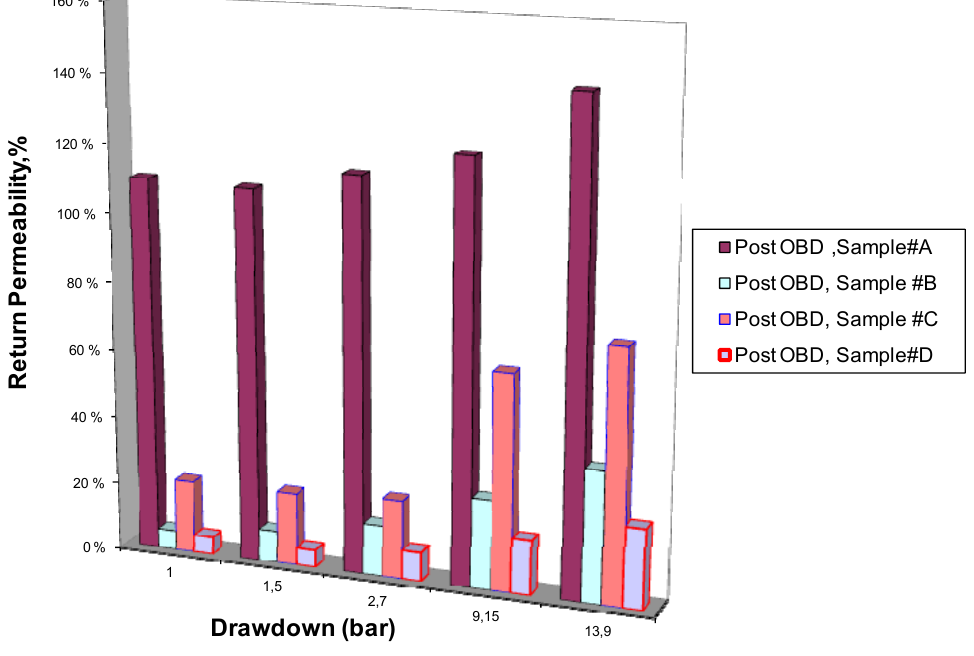
Figure 11. Return permeability results during short OB